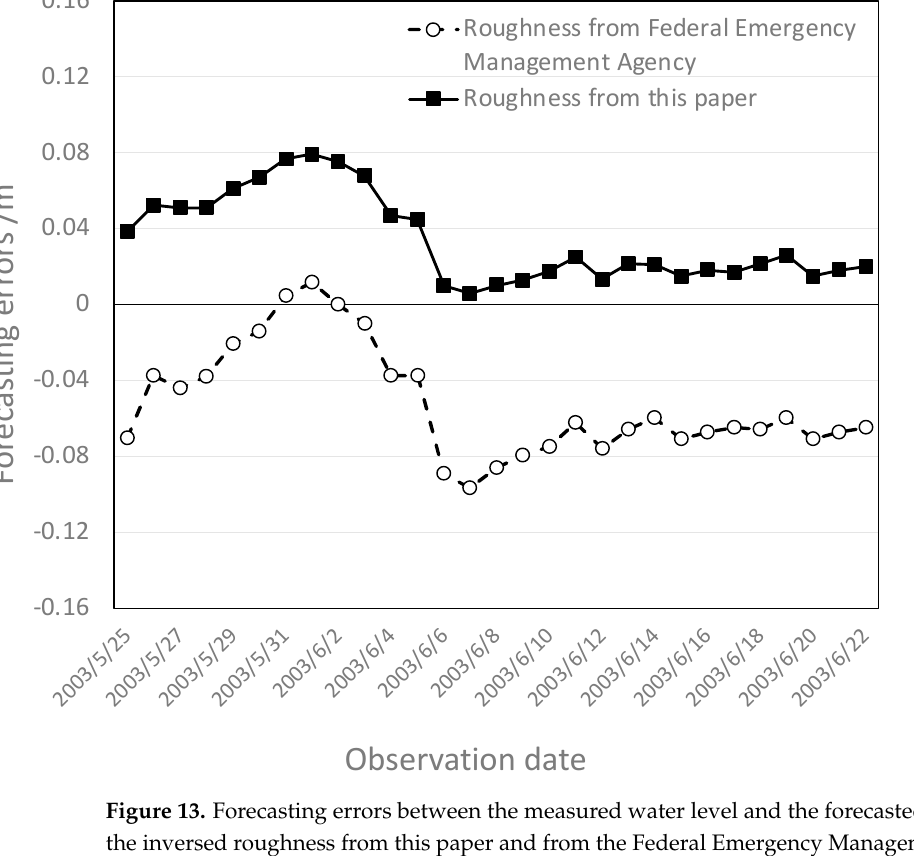
Figure 13. Forecasting errors between the measured water level and the forecasted values by using the inversed roughness from this paper and from the Federal Emergency Management Agency [23] .